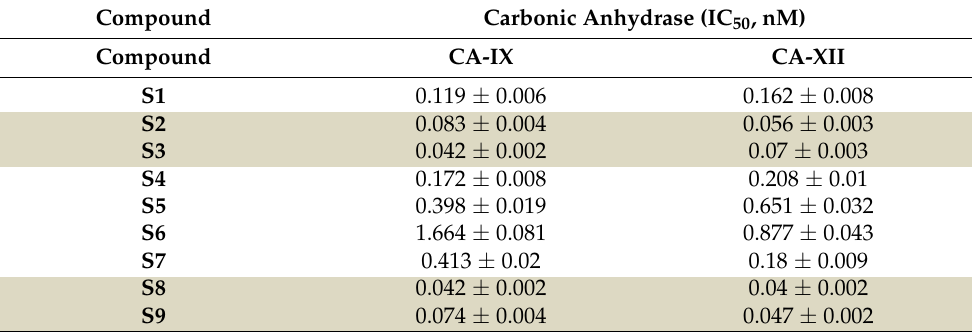
Table 1. Inhibitory activity of compounds S1 – S22 against hCAIX, and hCAXII using Dorzolamide HCL as reference